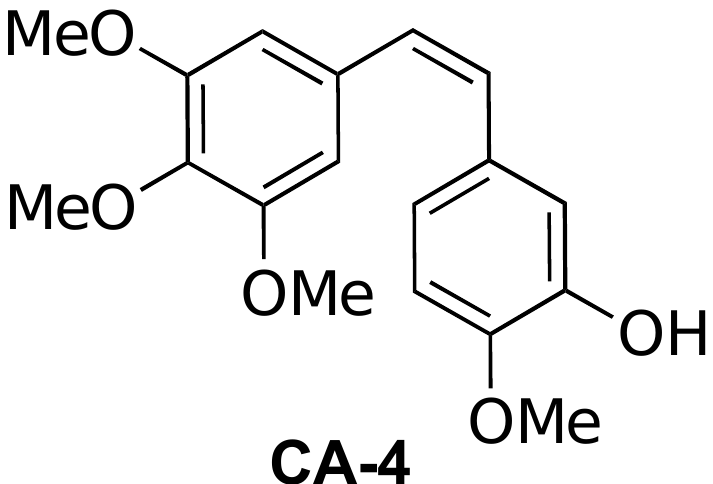
Figure 1. Chemical structure of cis Combretastatin A-4 (CA-4).